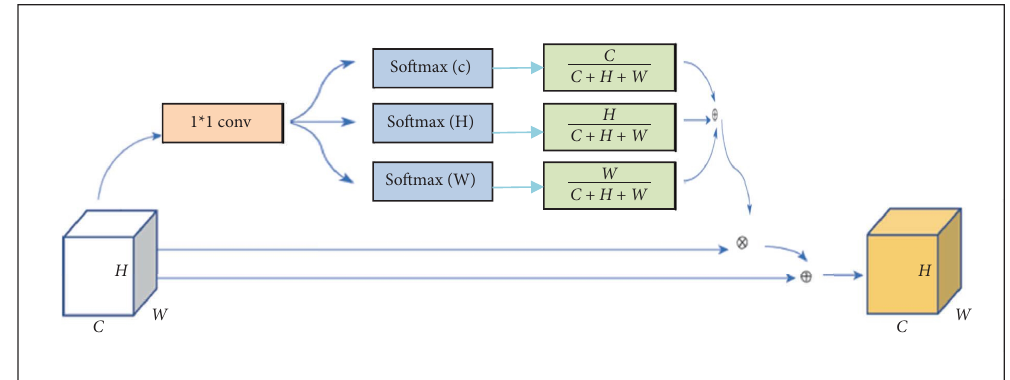
Figure 6: Structure diagram of the DA branch attention